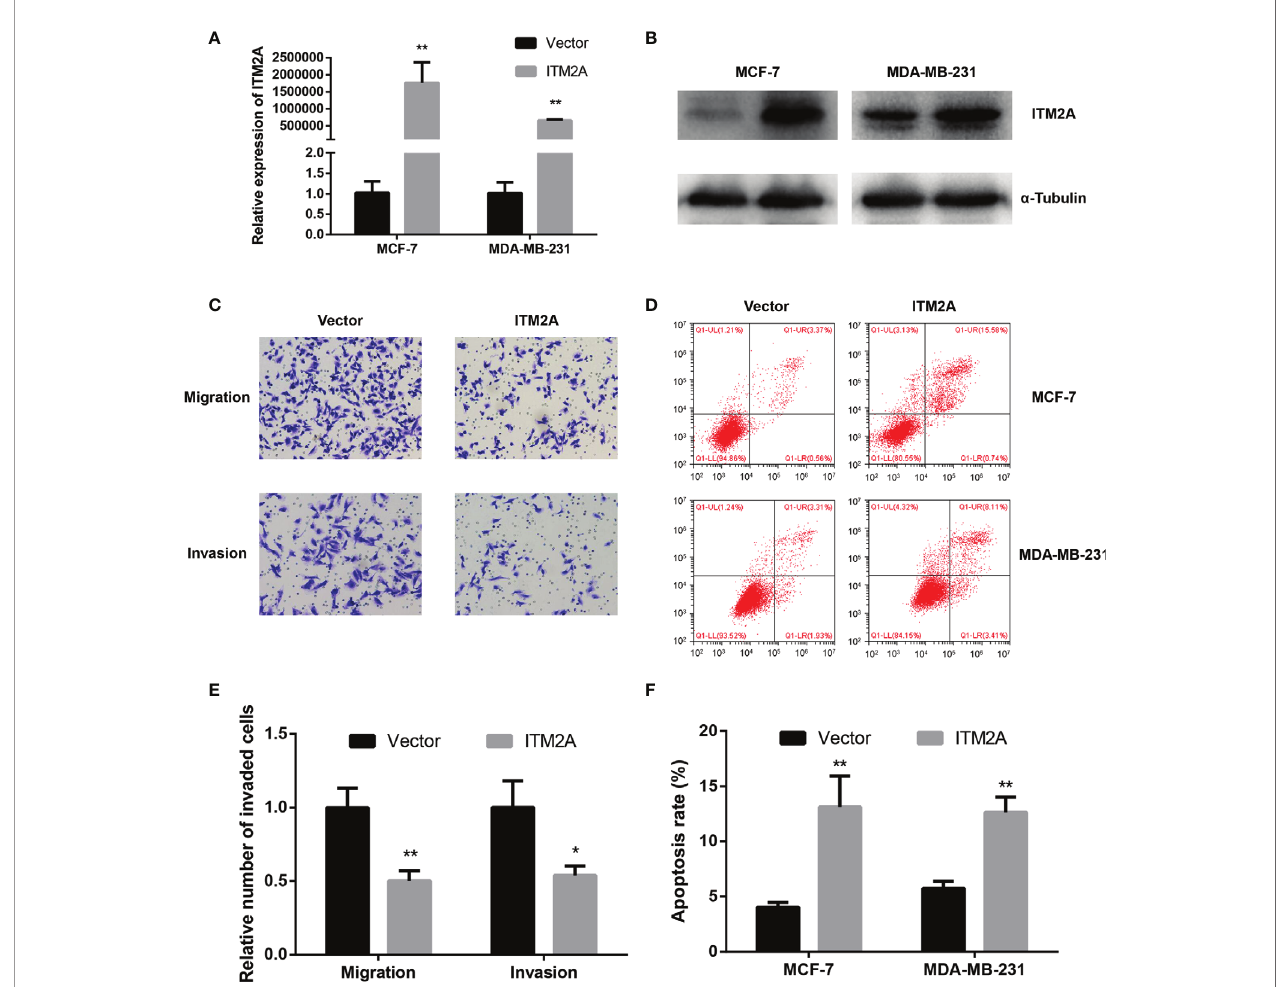
FIGURE 2 | Overexpression of ITM2A inhibited migration and promoted apoptosis of breast cancer cells. MCF-7 and MAD-MB-231 cells were transfected with the indicated plasmid. qRT-PCR (A) and immunoblotting (B) were used to test ITM2A expression in mRNA and protein levels 48 hours after transfection. (C, E) Migration and invasion assay in MDA-MB-231 cells. (D, F) Apoptosis rate in MCF-7 and MDA-MB-231 cells 48 hours after transfection. *p < 0.05, **p <